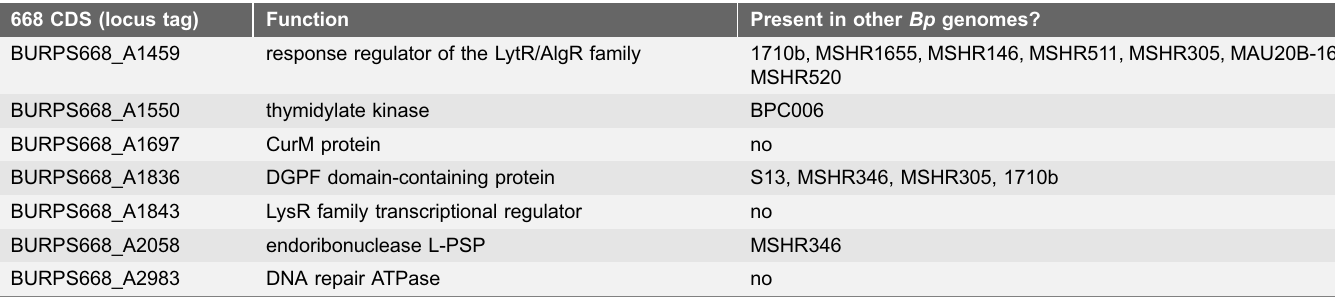
MSHR668 but absent in K96243 and 1106a (and vice versa). Our findings and the implications on our understanding of melioidosis as a disease are discussed below. Comparison of the three B. pseudomallei genomes revealed genomic differences that included the previously reported variability in GIs [7, 19], which were likely acquired by horizontal transfer [19], as evidenced by their proximity to transposases, integrases, tRNA genes, and the presence of phage-related genes within the GI. This variability in the GI regions may contribute to virulence potential, particularly because these regions can encode a broad array of functions [20]. The intracellular life cycle and adaptation of a pathogen to the host cell environment depends on the expression of virulence factors, which is controlled by regulatory elements, and may be affected by the metabolic state of the pathogen [41]. The genomes of B. pseudomallei MSHR668, K96243, and 1106a contained complete gene sets for the core pathways comprising carbon metabolism. They also contained gene sets encoding transporters and utilization pathways for a wide range of carbon substrates, anapleurotic reactions and fatty acid